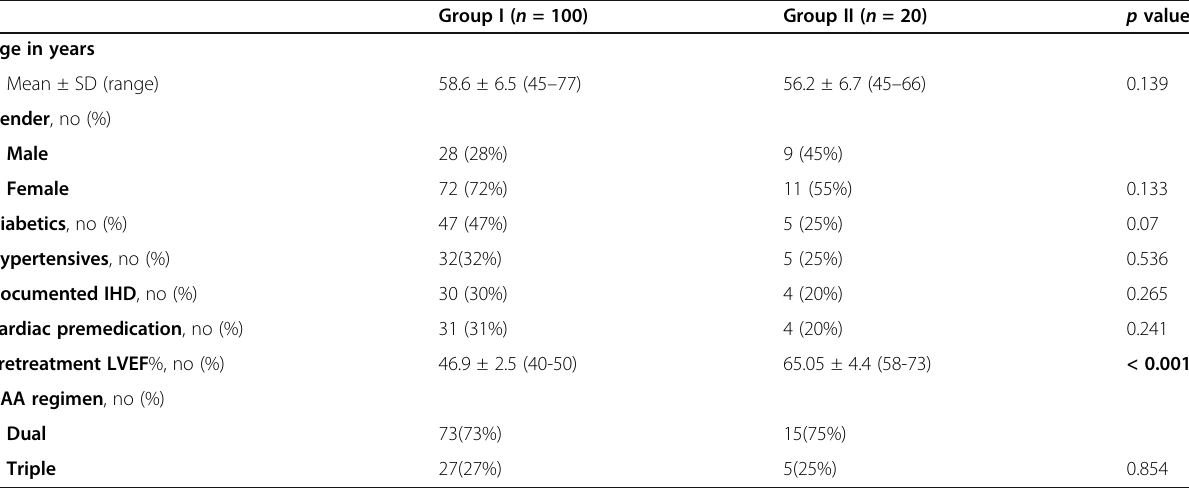
Table 1 Demographic and clinical data, received DAA regimen at study